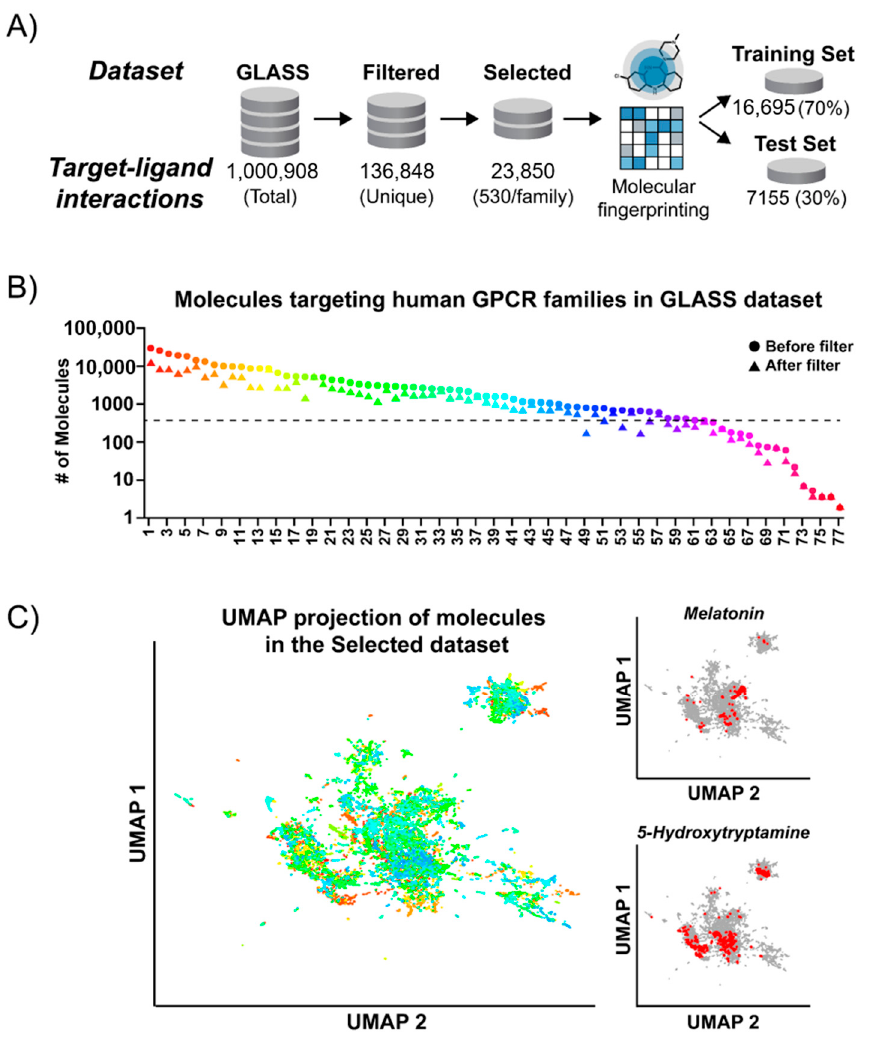
Figure 1. Processing and analysis of GPCR-ligand interaction data. ( A ) Data processing scheme for preparing the training and test datasets for machine learning. Compounds from the GLASS database with known CHEMBL IDs were filtered for unique interactions with human GPCRs followed by removal of redundant structures and random selection of 530 unique interactions for each GPCR family. Compounds in the Selected dataset were encoded as molecular fingerprints and split into training and test datasets. ( B ) The number of compounds interacting with each GPCR family in the GLASS dataset before and after processing. GPCR family names are shown in Supplementary Materials Table S1. ( C ) UMAP projection of compounds in the Selected dataset highlights the spatial clustering of unique scaffolds used to train the machine learning model. For visualization, the UMAP algorithm embeds the multi-dimensional molecular fingerprints of the training set into a two-dimensional representation (UMAP 1 and UMAP 2) while preserving the essential topological structure of the data. Each compound is represented by a single point and colored according to its GPCR family interaction as in ( B ). Inset UMAP projections (right) show examples of the dense clustering observed for compounds interacting with specific GPCR families, highlighting the separation of family-specific ligands.